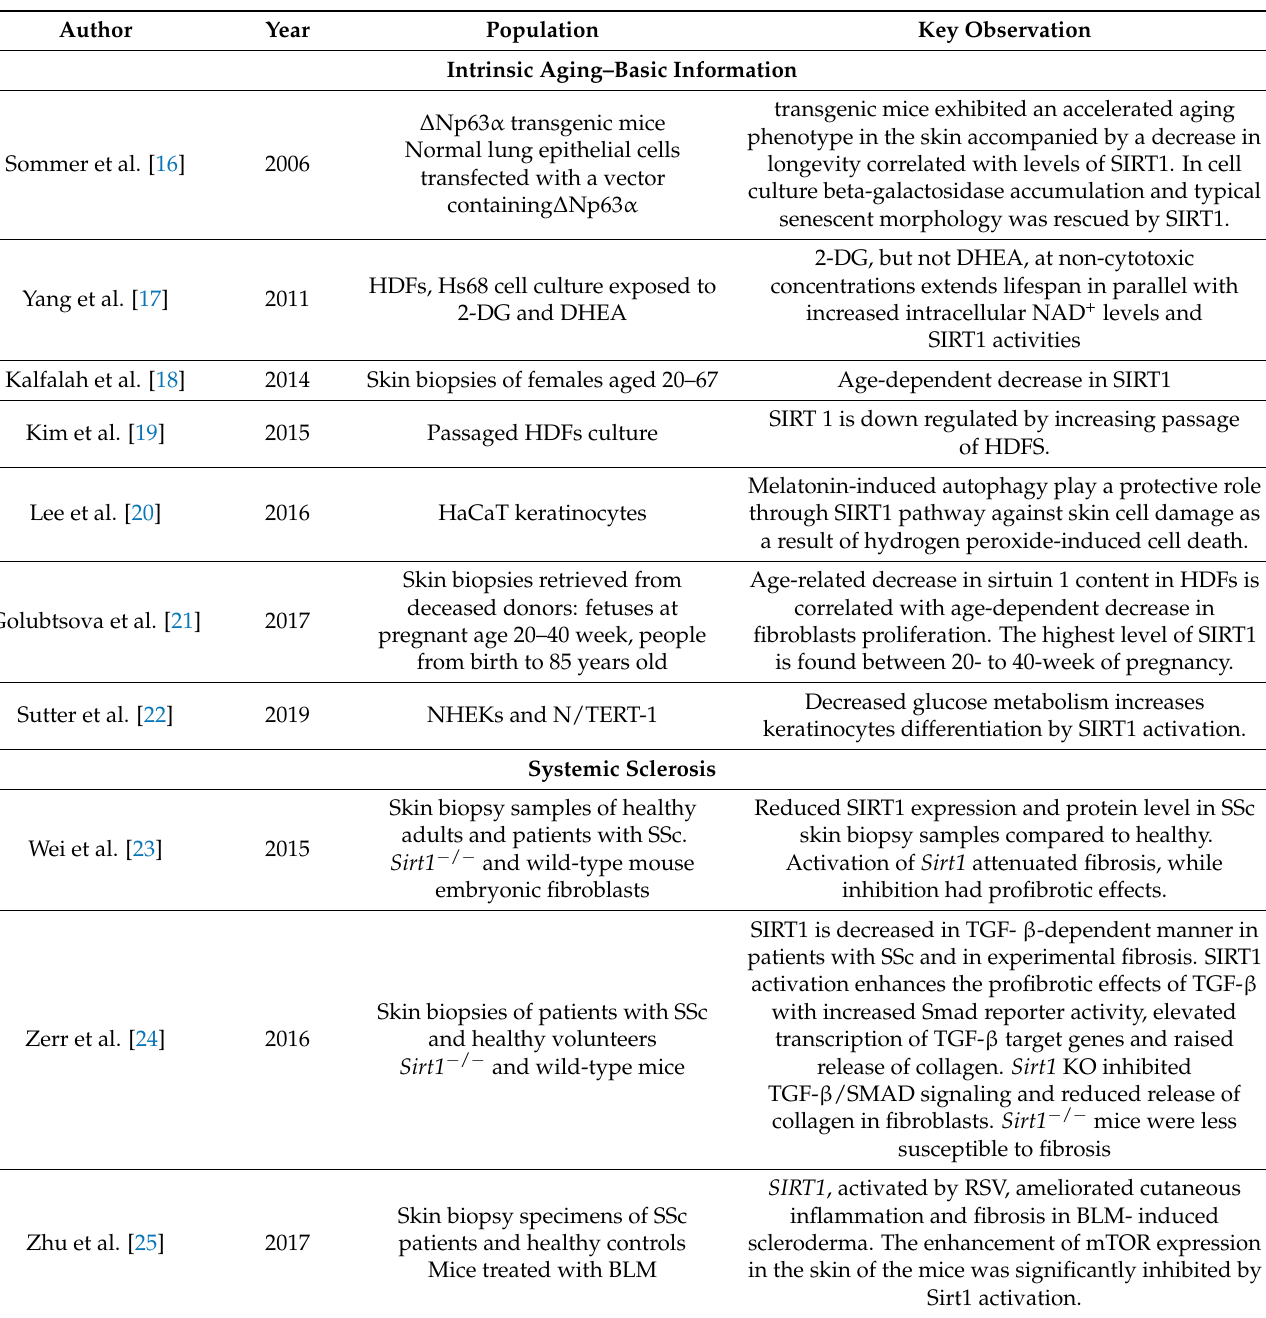
Table 1. Summary of the studies on SIRT1 relevance in intrinsic